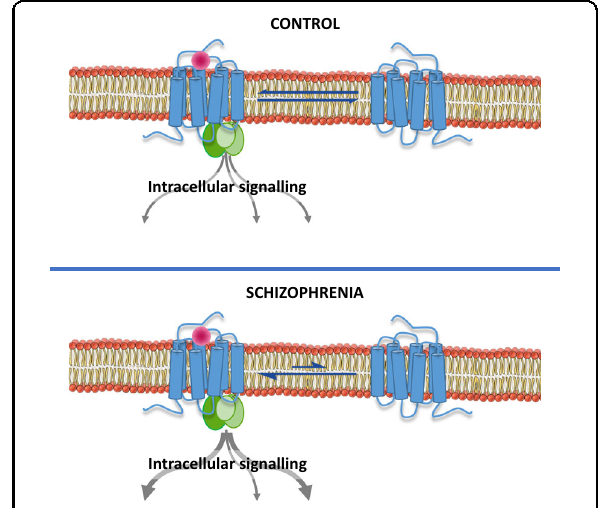
Fig. 2 Representation of the imbalance between 5-HT 2A R conformations towards the state preferentially labelled by agonists observed in the prefrontal cortex of subjects with schizophrenia. The disequilibrium promotes a G-protein overactivation in response to 5-HT 2A R agonists 20 . Based on this hypothesis, agonist radioligands should identify higher binding sites and inverse agonist radioligands should label lower binding sites in schizophrenia than in controls. Antagonist radioligands would not discriminate between schizophrenia and control